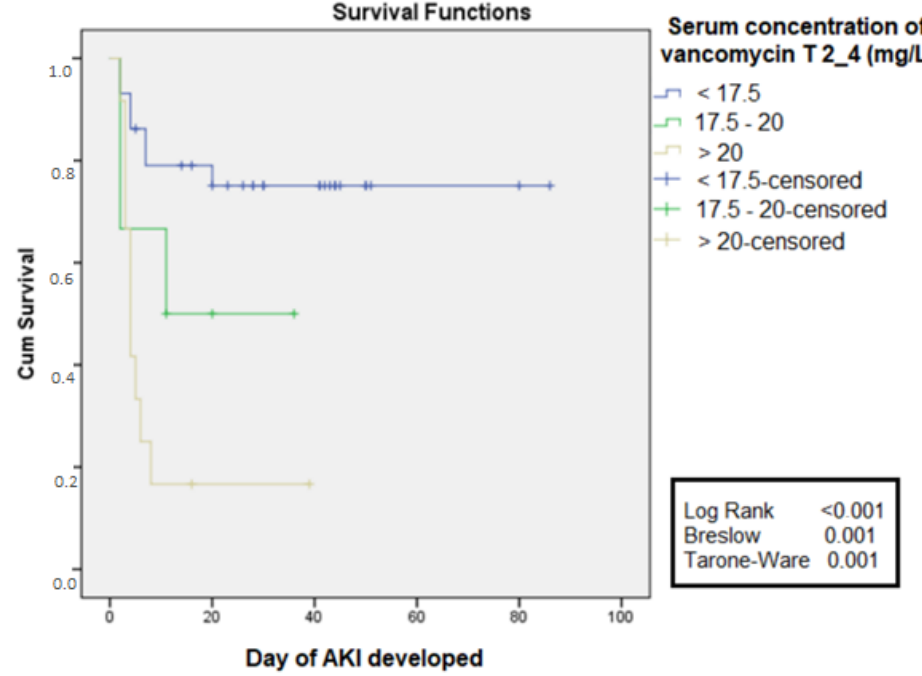
Figure 3. Free time for acute kidney injury according to the values of serum concentration between T2-4 days (48–96 h) use of vancomycin in septic patients in ICUs. Table 4 shows the clinical and laboratory variables, and Table 5 shows the character- istics related to vancomycin, distinguishing patients who died or survived. Table 4. Patients’ clinical and laboratory characteristics in the use of vancomycin hospitalized in an intensive care unit, compared to its outcome. Variables